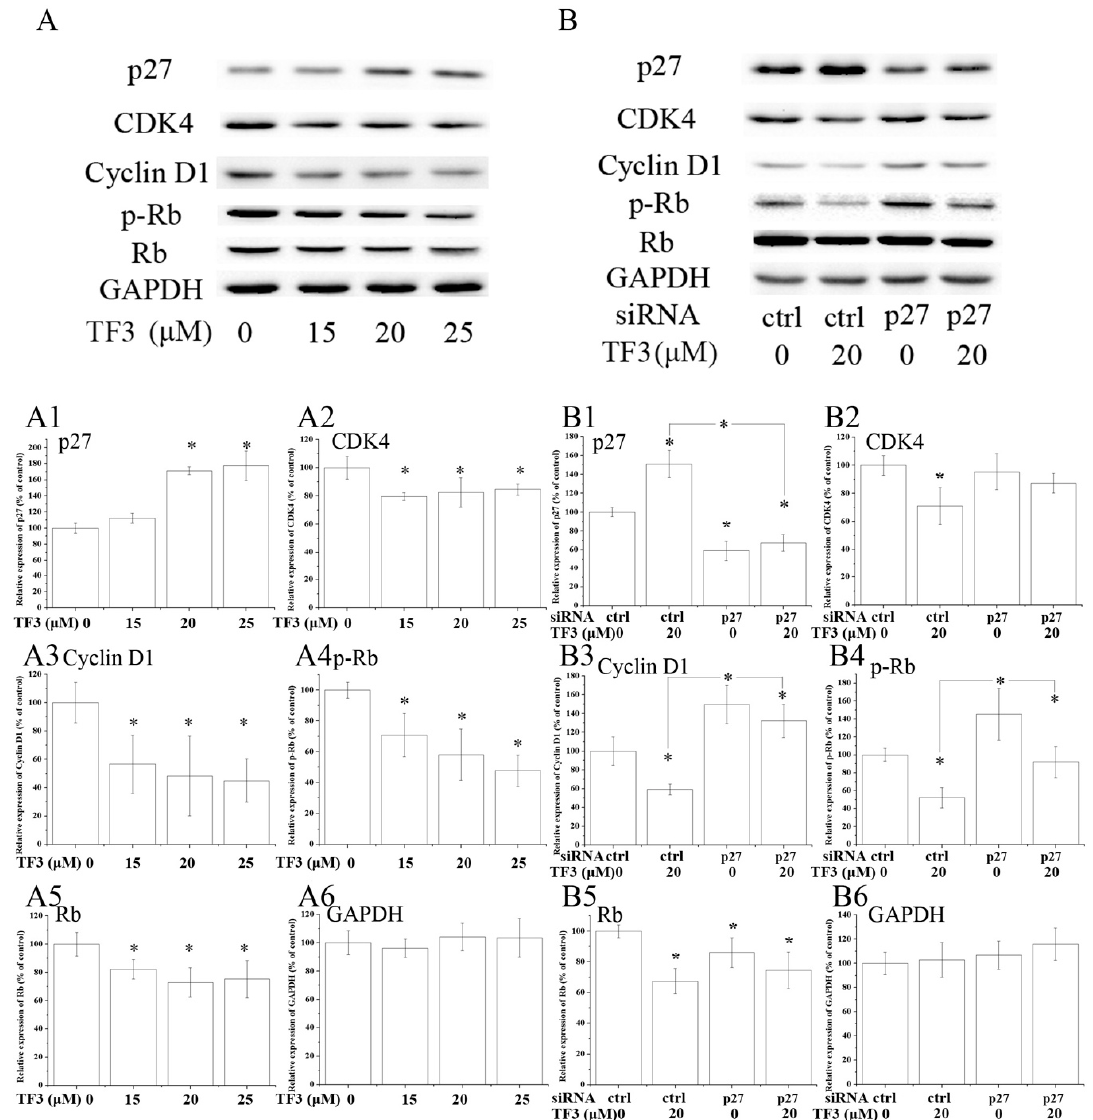
Figure 4. TF3 caused G0/G1 cell cycle arrest in OVCAR-3 cells by up-regulating p27 kip1 (p27). ( A ) Western blot analysis of TF3-treated OVCAR-3 cells. ( B ) Knockdown of p27 partially reversed TF3-induced decrease of the expression of cyclin dependent kinase (CDK)4, Cyclin D1, phospho-retinoblastoma protein (p-Rb) and retinoblastoma protein (Rb) in OVCAR-3 cells. ( A1 – A6 & B1 – B6 ) Densitometry analysis of protein bands. Glyceraldehyde-3-phosphate dehydrogenase (GAPDH) served as the loading control. * p < 0.05 compared with control or between specific groups. Table 2. Knockdown of p27 partially abrogated TF3-induced G0/G1 cell cycle arrest. siRNA